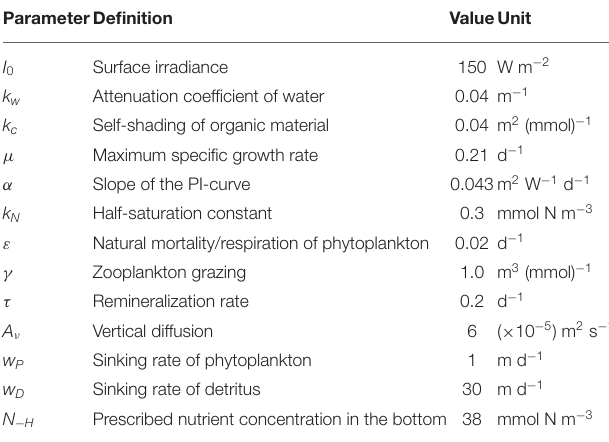
TABLE 1 | Definition and values of parameters used in the